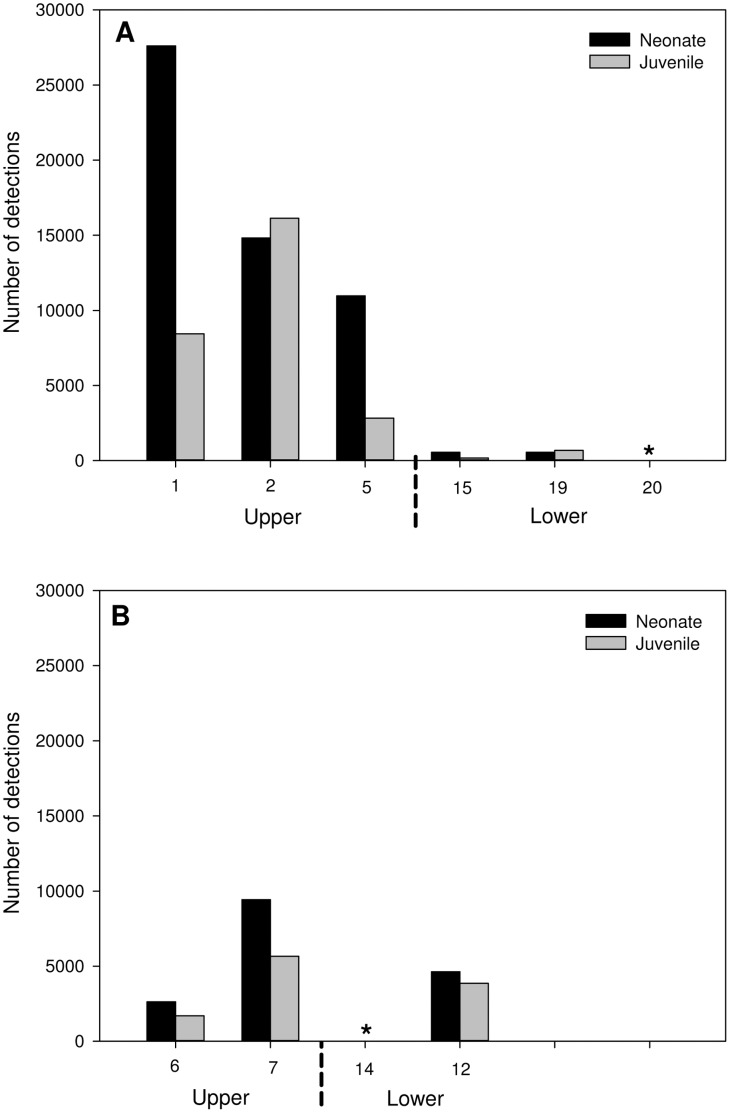
Total detections at individual acoustic receivers for all neonate and juvenile bull sharks tagged with acoustic tags in the Gold Coast system.Numbers on the × axis refer to individual stations (see Figure 1) for river (A) and canal (B) habitats. River numbers correspond to upper river on the left to lower river on the right. Upper canal (6 and 7) and lower canal (14 and 12) are shown accordingly. Asterisk denotes stations with<15 detections.